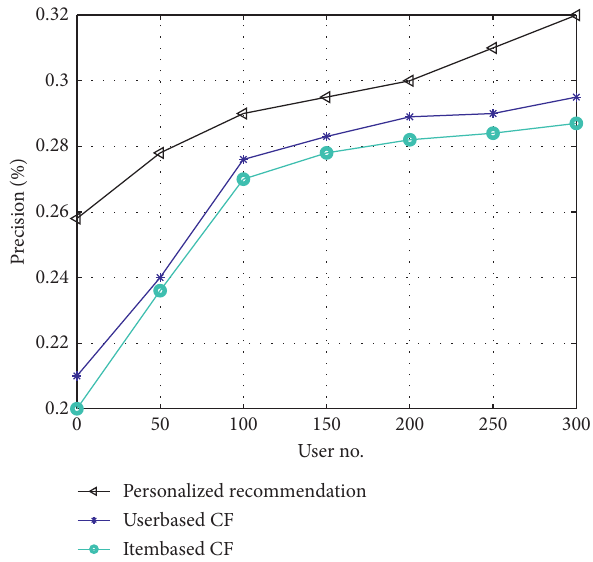
Figure 5: Comparison of the accuracy of recommended